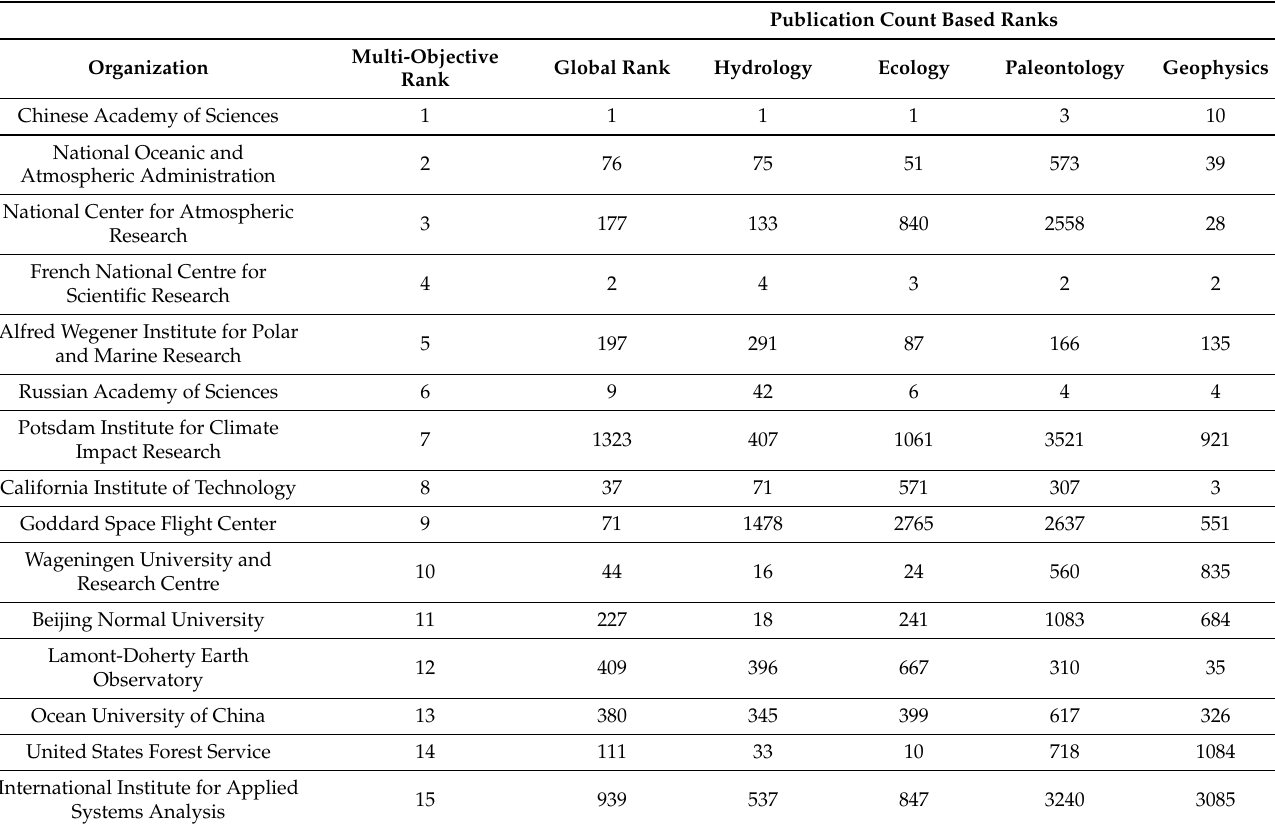
Table 4. Comparison between the ranks based on the publication count in sustainability science and climate change and the multi-objective rank created by the multidimensional